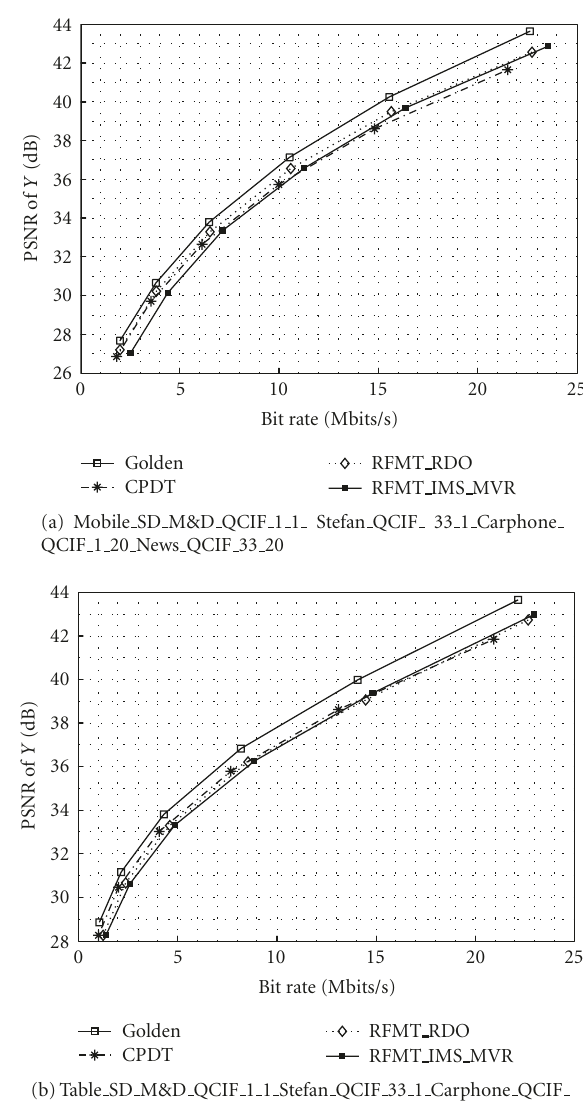
Figure 13: Rate-distortion performance of the luminance compo- nent by one foreground embedding for Mobile SD Foreman QCIF.